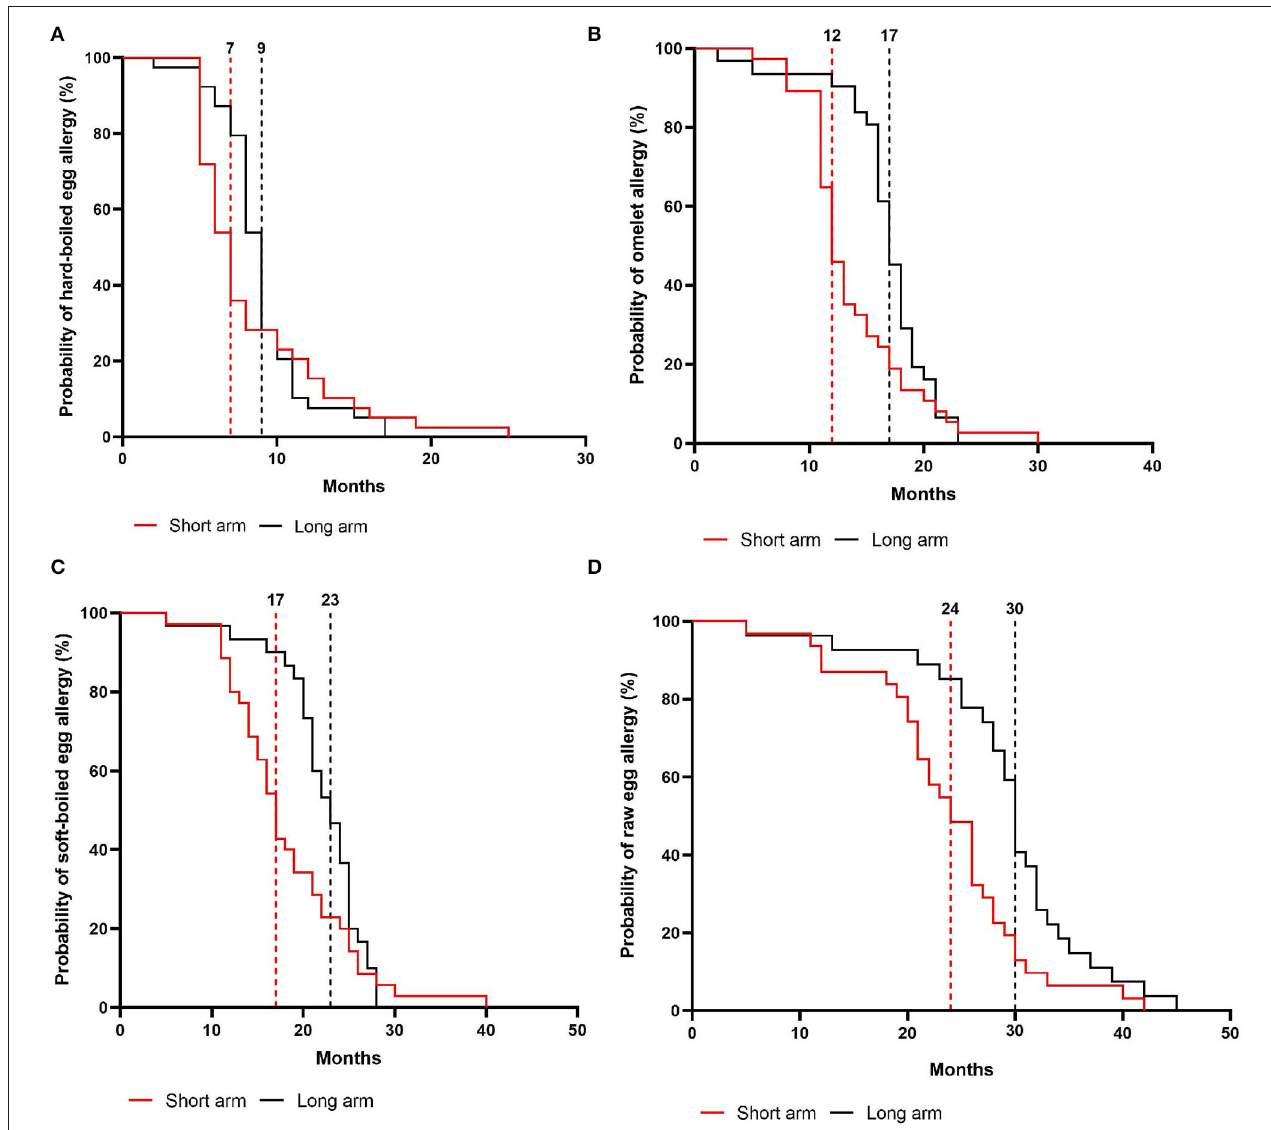
FIGURE 4 | Cox regression analysis of the step-wise egg-tolerance induction over time in the intention-to-treat group. (A) hard-boiled egg resolution over time (SA: n = 39, LA: n = 39) (B) omelet resolution over time (SA: n = 37, LA: n = 32) (C) soft-boiled egg resolution over time (SA: n = 35, LA: n = 31) (D) raw egg resolution over time (SA: n = 31, LA: n = 27). SA, short arm protocol; LA, long arm